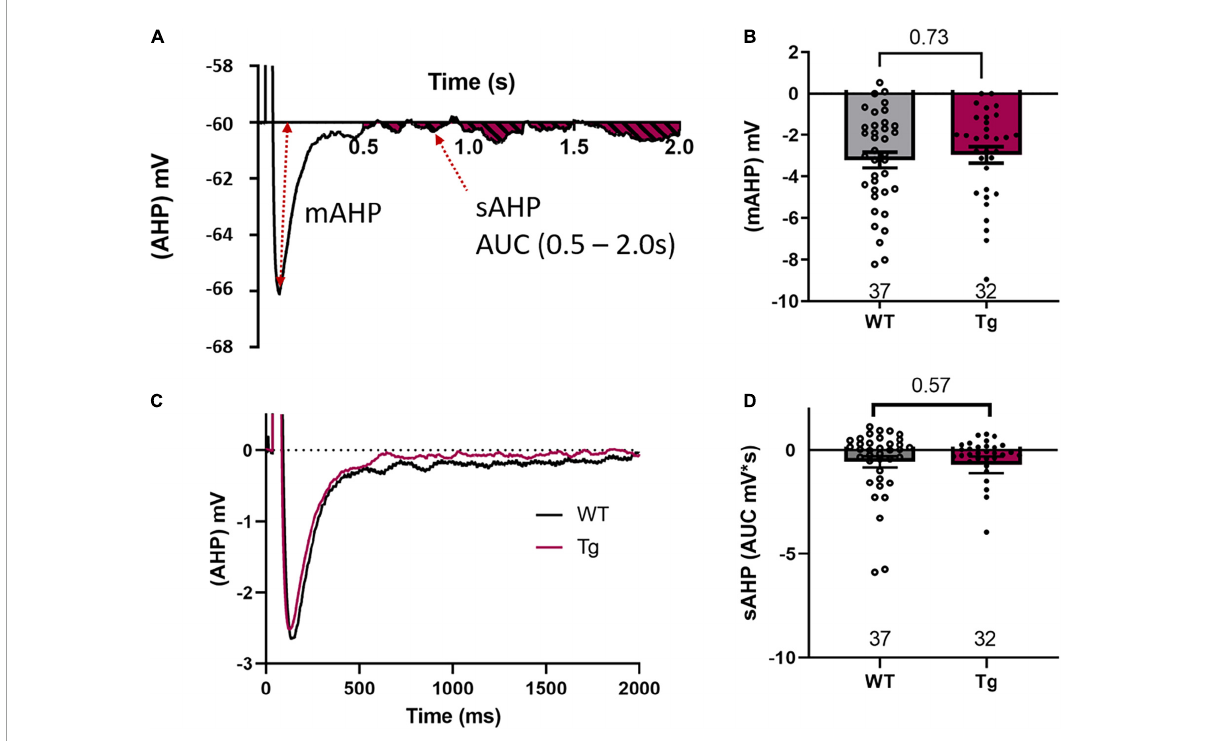
FIGURE4 mAHP or sAHP are not different between genotypes. (A) A representative trace to indicate the measurement of the medium after-hyperpolarization (mAHP) and the area under the curve (AUC) measurement between 500 and 2000 ms of the slow after-hyperpolarization (sAHP). (B) mAHP results show no difference between the WT and the Tg animals. (C) A grand average of all WT and Tg AHP experiments indicates no difference in either the mAHP or the sAHP between the two genotypes. (D) The AUC measurements of the sAHP are not different between the two